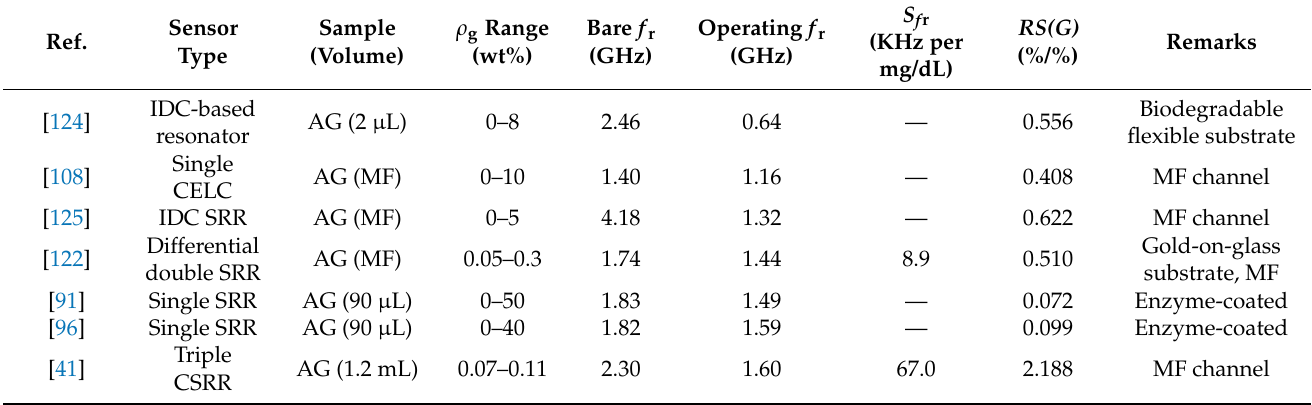
Table 1. Resonant frequency-based sensors. AG = aqueous glucose solutions; (C) SRR = (complementary) split-ring resonator; (C) ELC = (complementary) electric LC resonator; ENG = epsilon negative; IDC = interdigital capacitor; MLIN = microstrip line; MF = microfluidic; SIW = substrate-integrated waveguide; TX = transmission; WGM = whispering gallery mode.